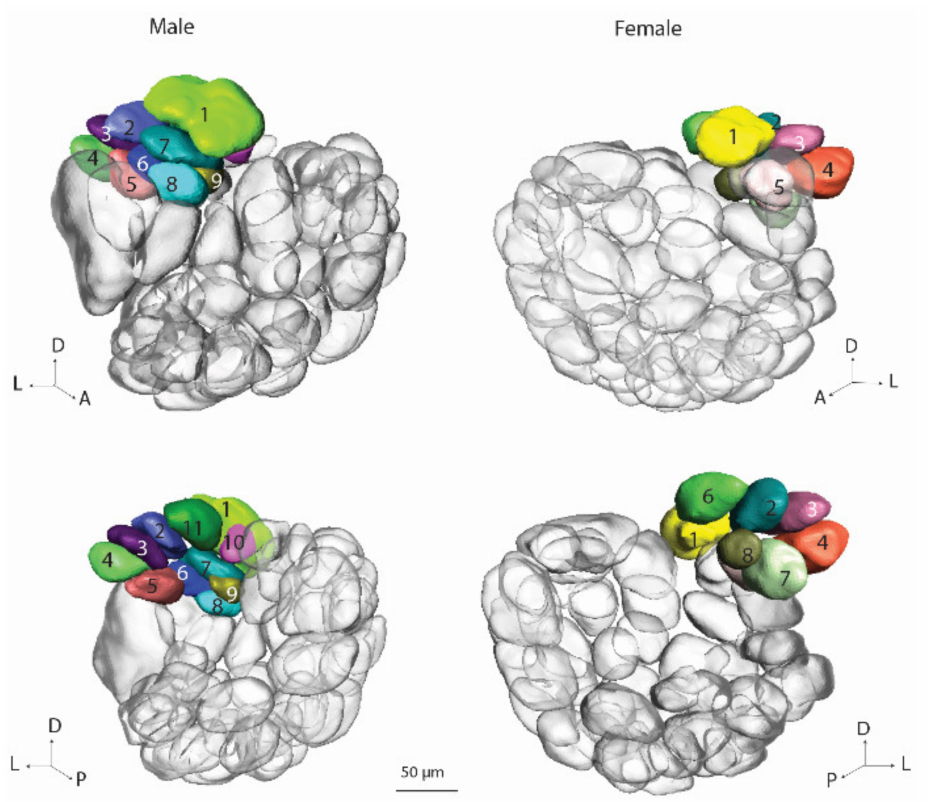
Figure 5. Three-dimensional reconstruction of the posterior complex in the male and female ALs of the gynandromorph: dorsal view ( top ) and ventral view ( bottom